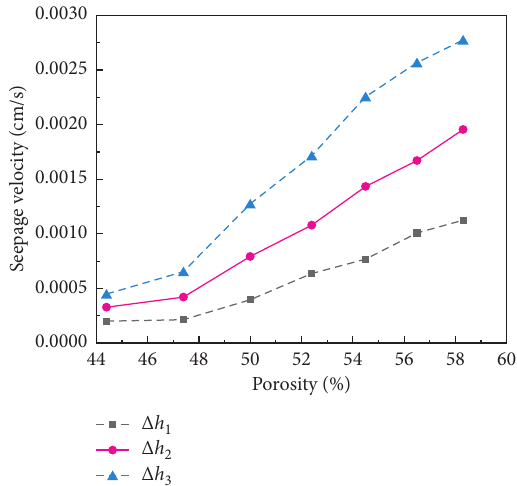
Figure 6: Relationship between seepage velocity and porosity.